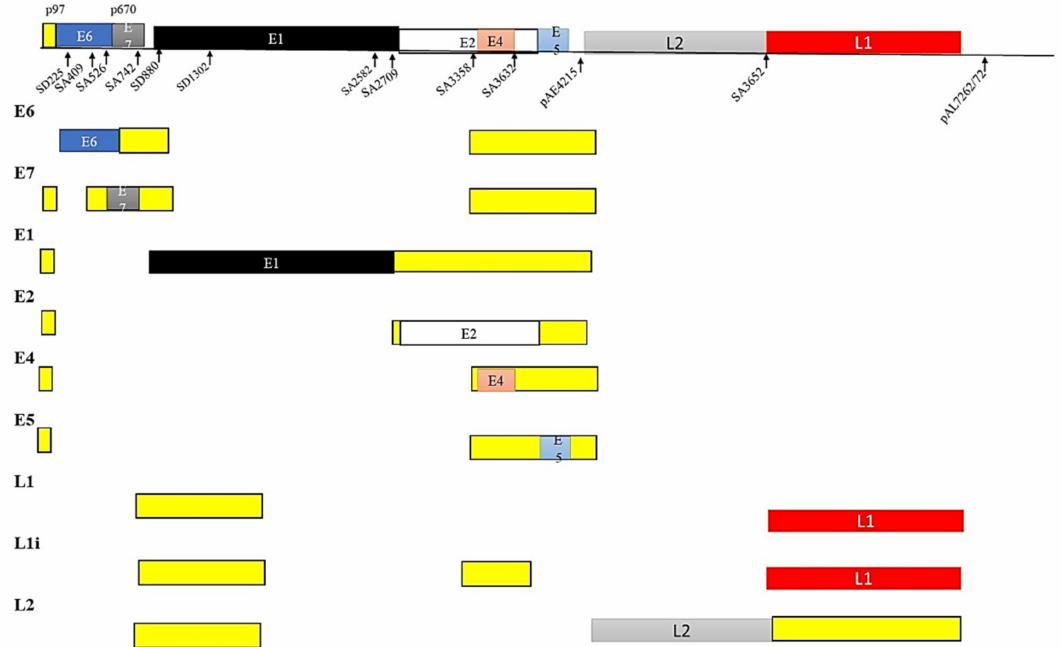
Figure 4. Splicing of the HPV genome. The DNA genome of HPV is made up of the long control region (LCR, not shown), the early region (E) and the late region (L). The LCR regulates transcription and replication. The genes of the early region control infection and virus expression, while genes of the late region code for the virus capsule proteins. Alternative splicing in HPV infection results from two different promoters in low-risk HPV and by a single promoter in high-risk HPV. Different isoforms of the E6 protein are found in high-risk